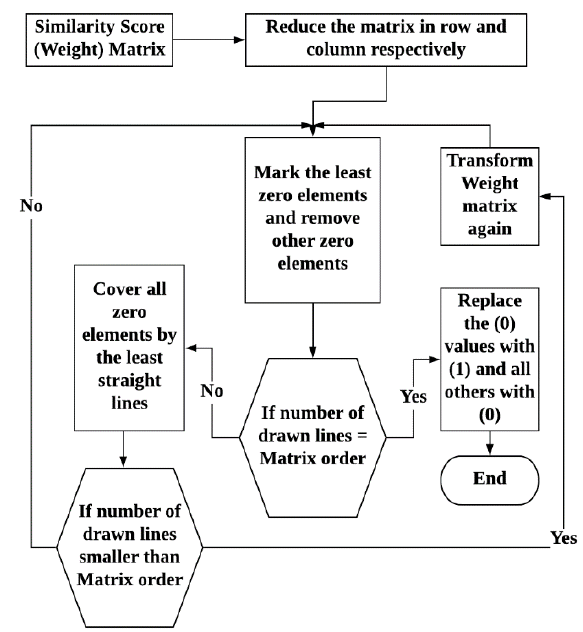
Figure 5. The Kuhn-Munkres algorithm for maximum weight matching